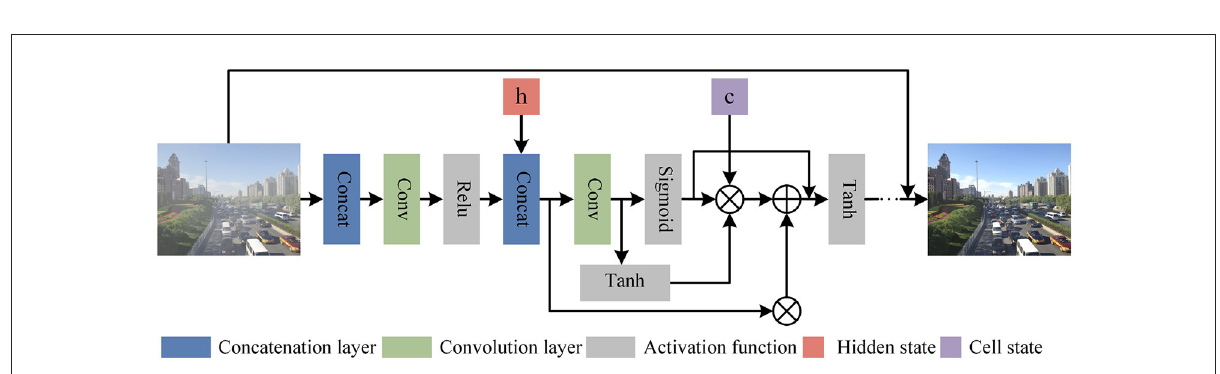
FIGURE4 Progressive recurrent block structure. ⊗ Represents Hadamard Product, and the corresponding elements in the matrix are multiplied. ⊕ Represents matrix addition operation.